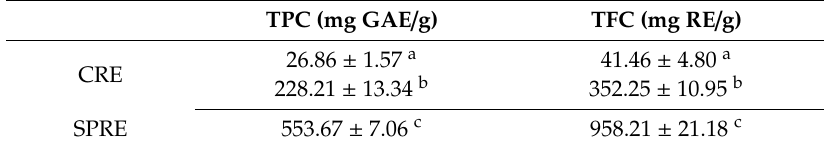
Table 1. Total phenolic content (TPC) and total flavonoids content (TFC) of the extracts and fractions of R. prinoides